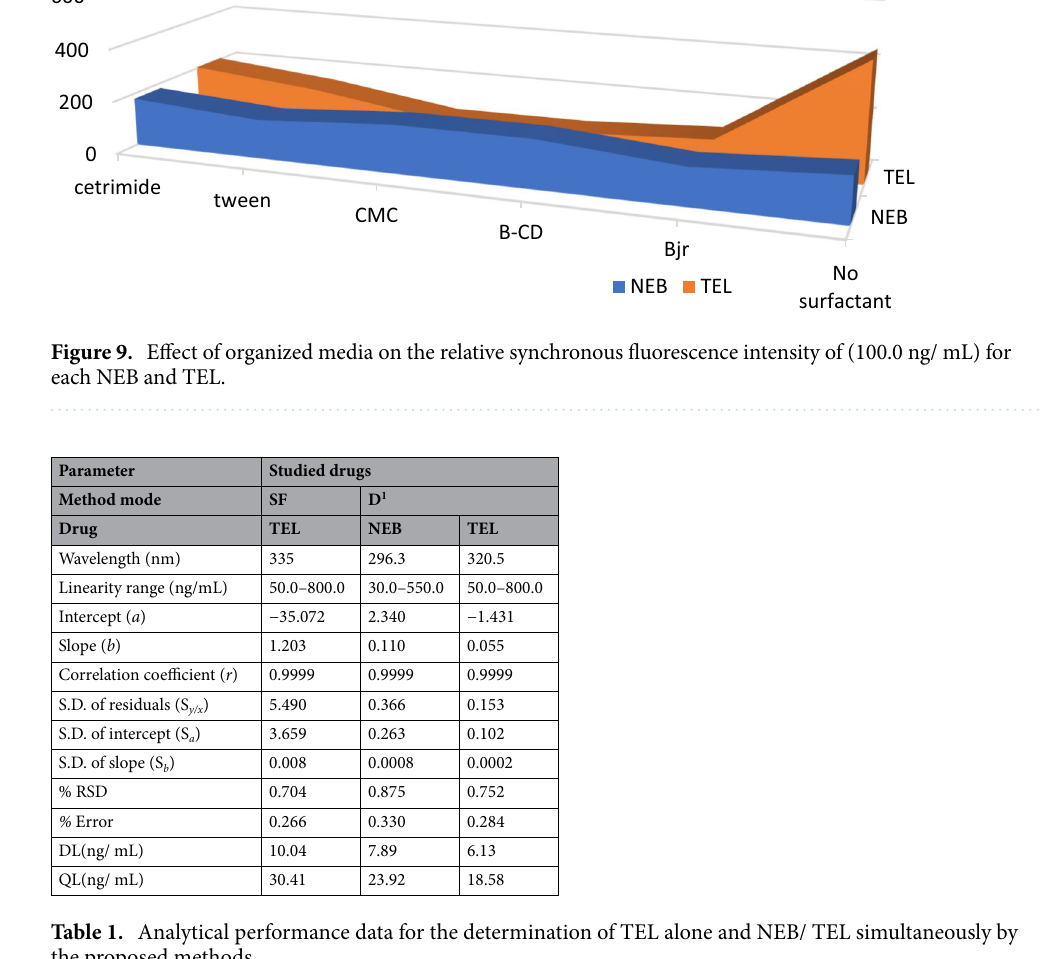
The obtained statistical analysis data confirmed calibration graphs’ linearity 45 as illustrated in Table 2.